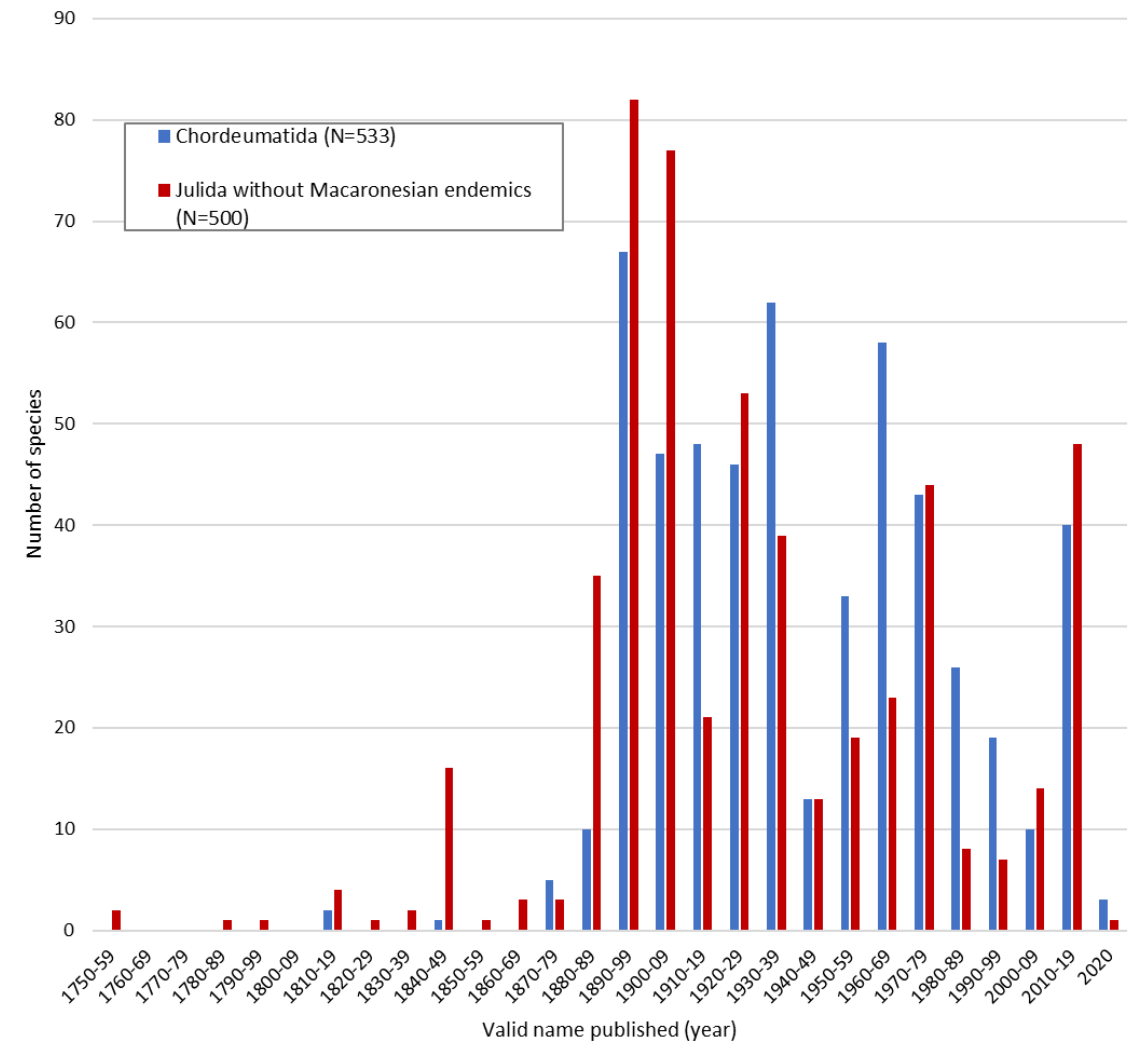
Fig. 8. Year (decade) of publication of valid names of European Chordeumatida C.L. Koch, 1847 (blue columns) and Julida Brandt, 1833 without Macaronesian endemics (red columns, data from Kime & Enghoff 2017 and from Table 5 of the present